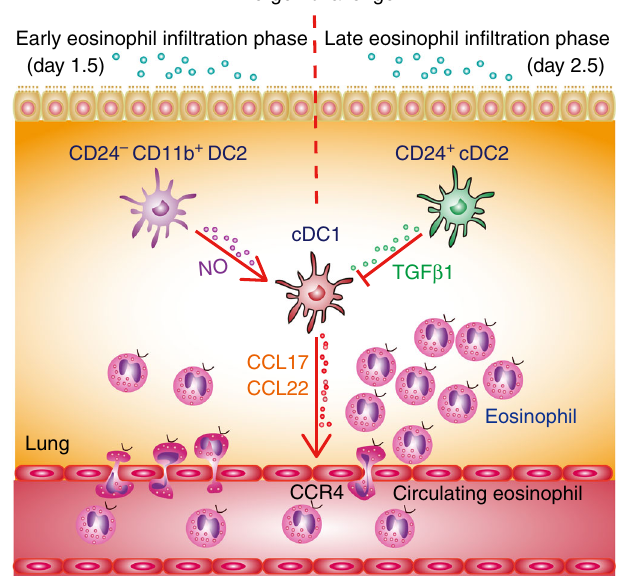
Fig. 6 Initial eosinophil recruitment is dynamically regulated by lung DC subsets. After allergen challenge, cDC1s directly recruit eosinophils by secreting CCL17 and CCL22, which are critical for early eosinophil in fi ltration. This cDC1-mediated eosinophil in fi ltration is dynamically modulated by other lung DC subsets. After allergen challenge, lung CD24 − CD11b + DC2s promoted eosinophil in fi ltration by producing NO on day 1.5, which promotes CCL17 and CCL22 expression by cDC1s, whereas CD24 + cDC2s inhibit this process by releasing TGF- β 1 on day